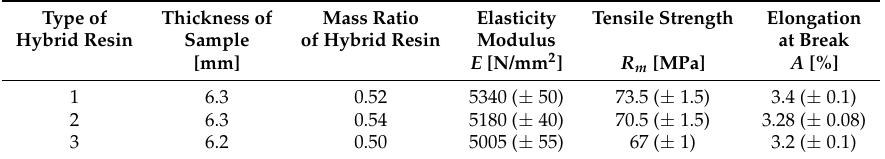
Table 5. The mean value with the standard deviation for elasticity modulus, tensile strength and elongation at break for composites with matrix of hybrid resin of type 1, 2 and 3, reinforced with the first type of flax fabric.